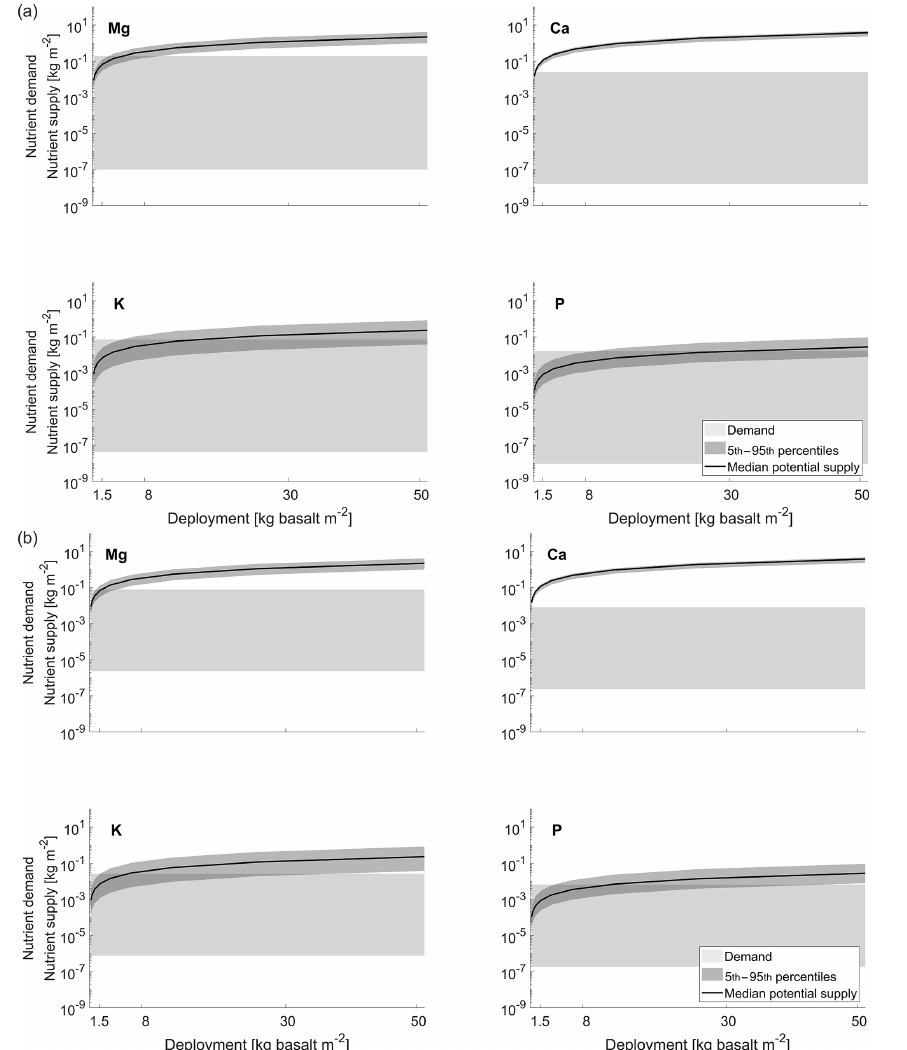
Figure 7. Mg, Ca, K, and P supply by basalt dissolution (logarithmic curve) given as medians and ranges (5th and 95th percentiles; dark grey areas). Horizontal filled boxes indicate the nutrient demand for the maximum (17.1gPm − 2 ) and minimum ( (cid:28) 1gPm − 2 ) gap of each geogenic P supply scenario for P and derived Mg, Ca, and K demand for balanced tree nutrition assuming mean foliar and wood material chemistry (Table 1). (a) Based on minimum and maximum P gap values of <1 and 16.6gPm − 2 , which were obtained for a geogenic P supply scenario one (geogenic P from weathering plus atmospheric P deposition as source of P). (b) Based on minimum and maximum P gap values of <1 and 6.7gPm − 2 , which were obtained for a geogenic P supply scenario two (geogenic P from soil inorganic labile P and organic P pools plus atmospheric P deposition and P from weathering as source of